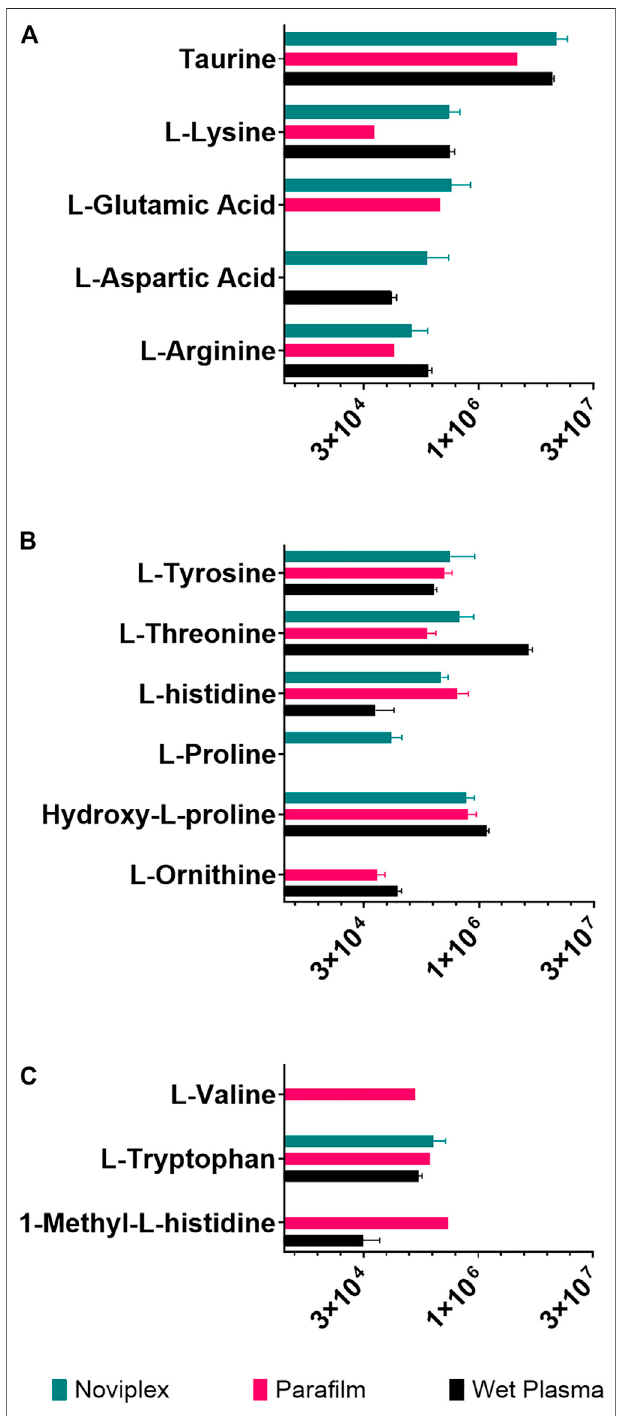
FIGURE 7 | The summed average area of chromatographic peaks (Gaussian smoothed) for amino acids grouped by hydropathy (A) Hydrophilic (B) Neutral (C) Hydrophobic for each sample processing method. The error bars indicate standard